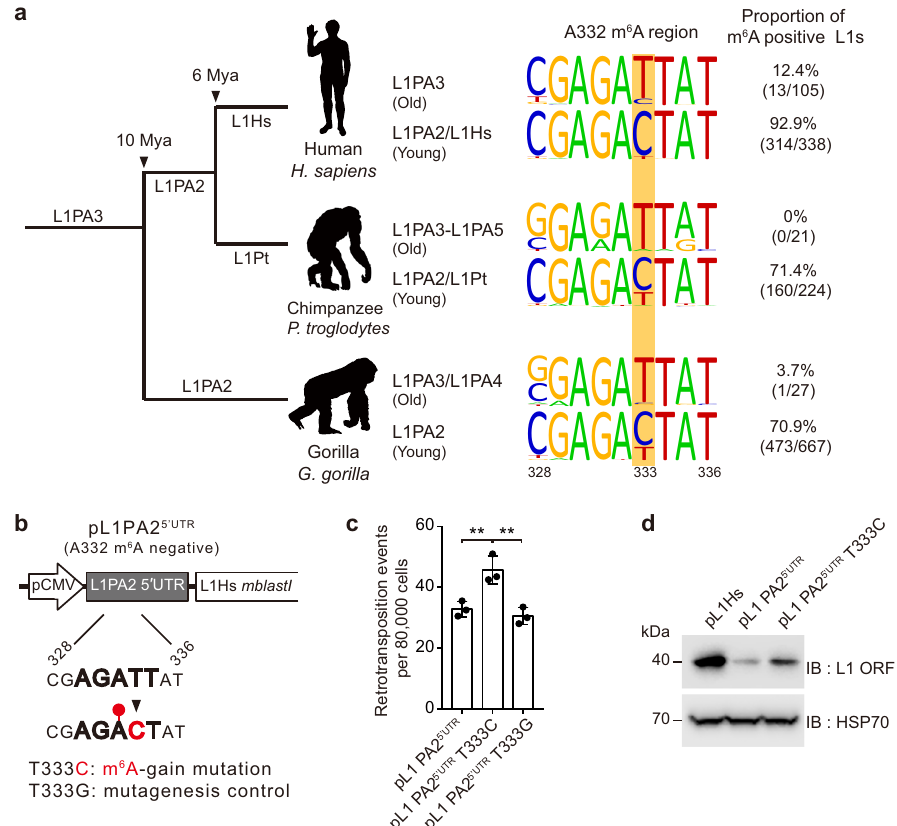
Fig. 6 m6A is a driving force in L1 evolution. a Comparative analysis of L1 A332 m 6 A sites in species-speci fi c full-length L1s from three primates. Phylogenetic tree of gorilla, chimpanzee, and human L1s with predicted age and the corresponding L1 subfamily lineages (left). Changes in the A332-m 6 A motif region from L1PA3 or older L1s to L1PA2 and a younger L1 (right). The substitution site wherein the residue converts from T to C (333) is highlighted in yellow. The percentage indicates the proportion of m 6 A motif-positive L1s with nucleotide C to total L1s. b A schematic of retrotransposition assay using pL1PA2 5 ′ UTR construct that is generated by substituting 5 ′ UTR of pL1Hs with A332 m 6 A negative 5 ′ UTR of L1PA2. A schematic of T333C m 6 A acquisition mutagenesis in L1 5 ′ UTR 328 – 336 region was indicated in red. c Retrotransposition assays for assessing the effect of A332 m 6 A acquisition in pL1PA2 5 ′ UTR with T333C mutation. T333G mutation served as negative control ( n = 3 independent samples, mean ± s.d., one-way ANOVA and Tukey ’